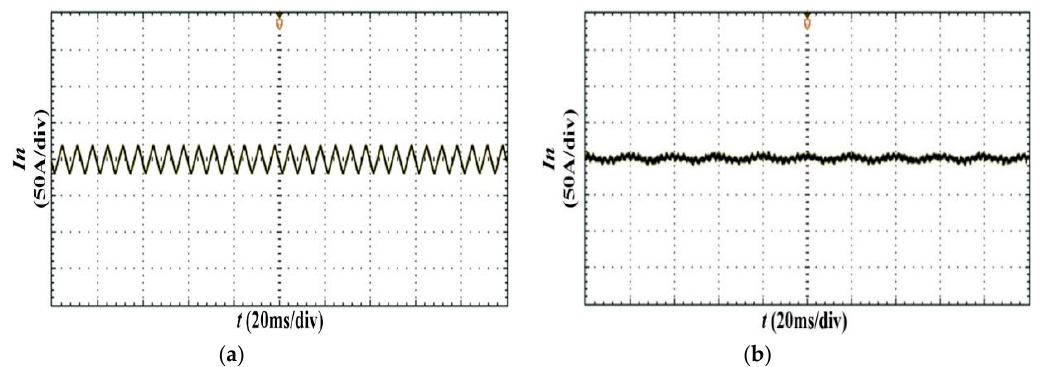
Figure 10. Neutral line current with the unbalance load when U sn = 220 V and U dc-ref = 640 V. ( a ) Without compensation; and ( b ) with compensation.